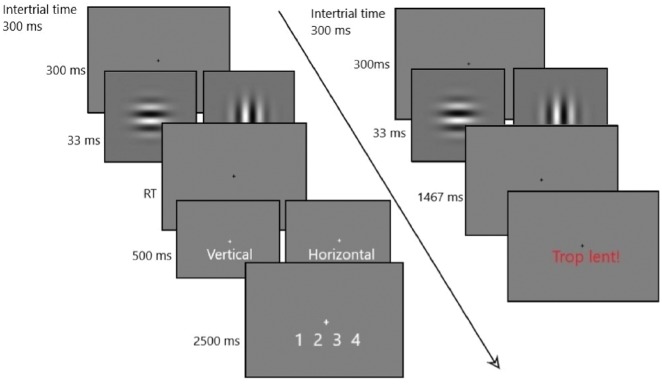
Trial sequence. Successfully completed trial (left). A fixation point was displayed for 300 ms. A Gabor patch (shown in the image) briefly appeared (33 ms) followed by another fixation point. Subjects were required to respond as quickly and accurately as possible according to whether the stimulus was oriented vertically or horizontally by pressing the appropriate key in <1500 ms. Following the response an answer confirmation was displayed for 500 ms. Subjects then had 2500 ms to verbally rate their confidence on a scale from 1 (low confidence) to 4 (high confidence). Failed trial (right). If a response was not provided in <1500 ms, the French words “Trop lent!” (“too slow”) were displayed, and the next trial began after 300 ms.